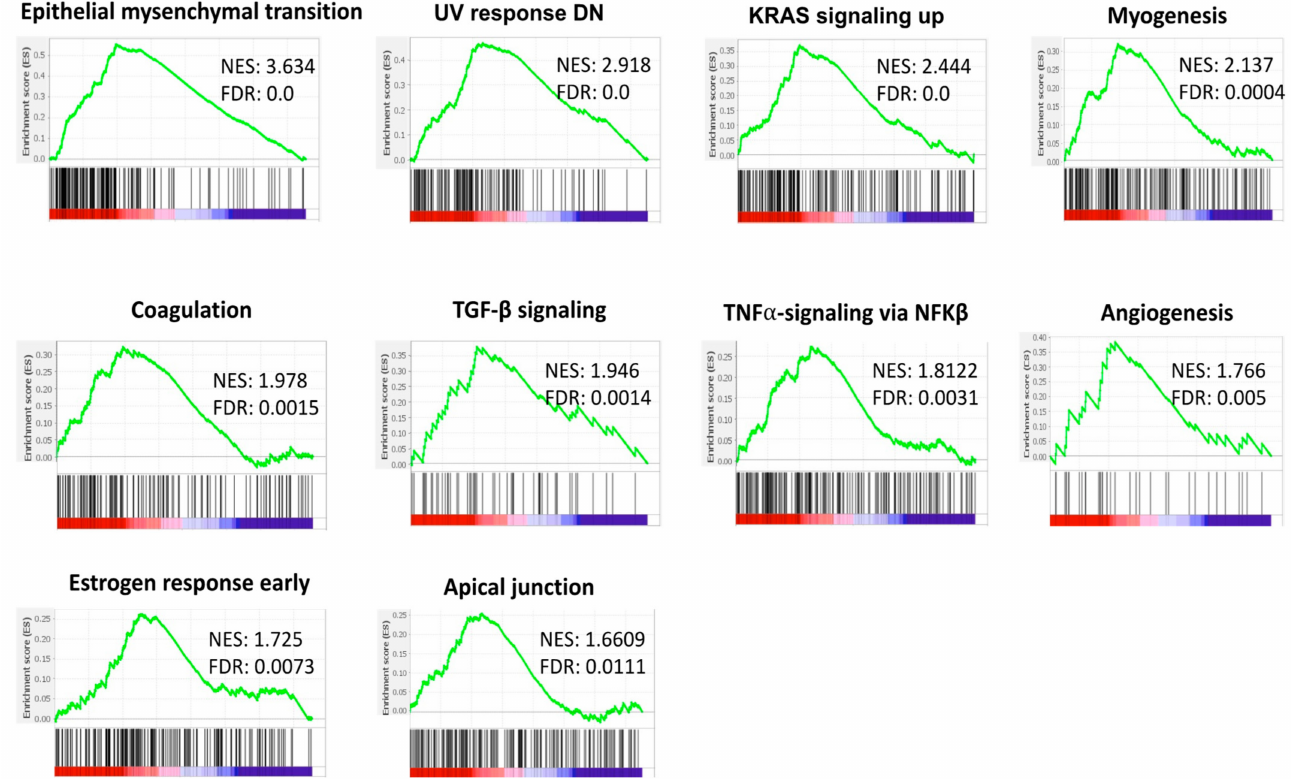
Figure 8. Results of gene set enrichment assay (GSEA) in high expression of LSM4 in breast cancer patients in TCGA cohort. From TCGA Pan-Cancer dataset, patients were split into two groups with low or high LSM4 mRNA expression; then a related ranked genes list was obtained and input to GSEA. From the GSEA software, statistical significance was considered as an FDR value < 0.25, normalized enrichment score (NES) > 1.5, and nominal p -value < 0.05, which was recommended by GSEA database. A positive NES value, which reflects the enrichment pathway in the list, represents the enrichment at the top of